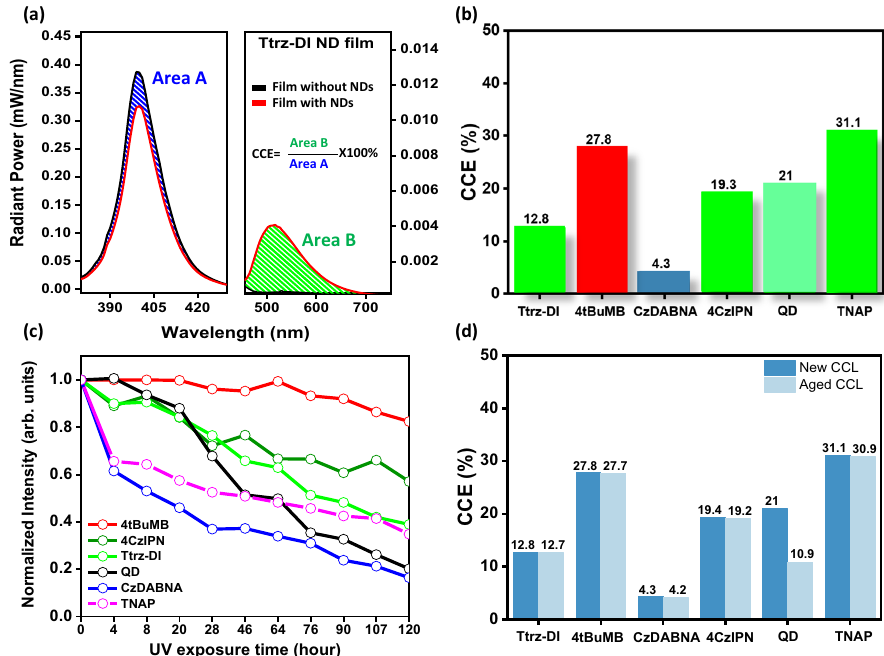
Fig. 4 Color conversion characteristics. a Color conversion ef fi ciency (CCE) of Ttrz-DI nano-dot fi lms used as color conversion layers. b Color conversion ef fi ciency comparison of 4CzIPN nano-dot fi lm, Ttrz-DI nano-dot fi lm, 4tBuMB nano-dot fi lm, and QD fi lm. The color of each bar corresponds to the emission color of each fl uorophore. c Stability test of nano-dot fi lms under constant UV exposure. d Color conversion performance stability of new and aged fi